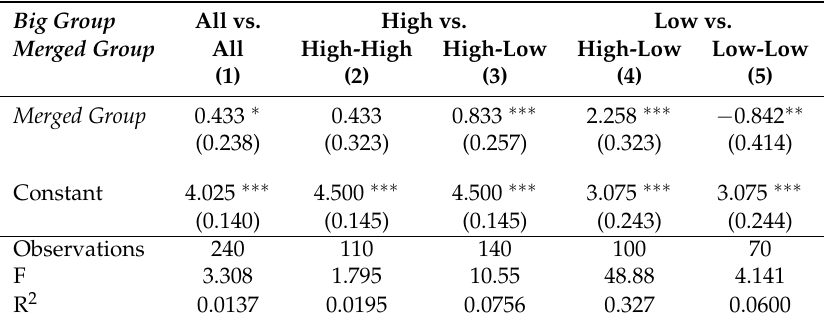
Table A1. Linear regressions: #Helpers in Part B.